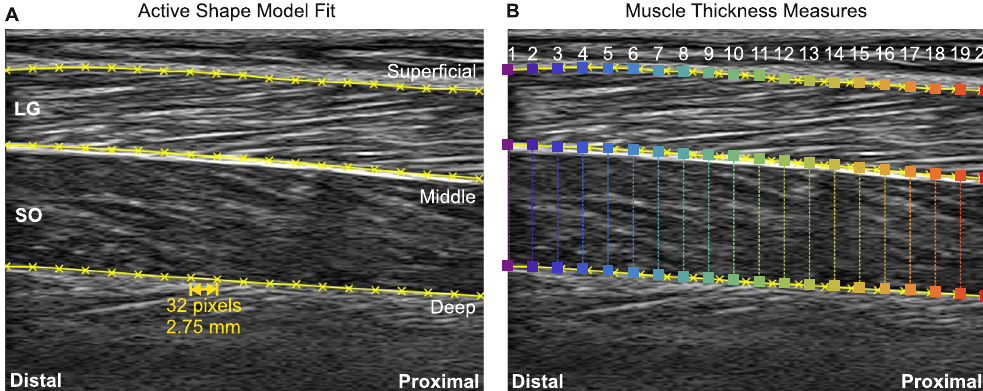
Figure 1. ( A ) Example ultrasound image of lateral gastrocnemius and soleus muscles, with each of the aponeuroses fit with the active shape model (yellow). The fit provided 19 points along each aponeurosis, separated by 32 pixels (2.75 mm). ( B ) Representation of the 20 point landmarks distributed along each aponeurosis shape model fit (coloured squares). Coloured vertical lines represent thickness measures recorded in soleus. The colour scheme is used in following figures to indicate the distal-proximal location of reported thickness